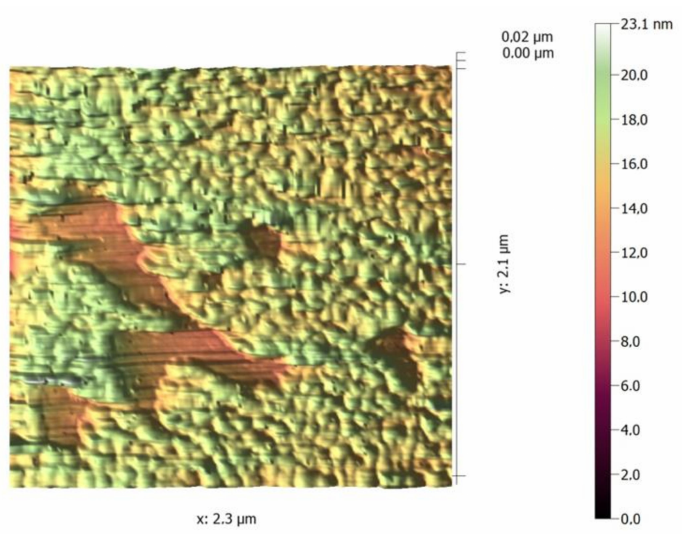
Figure 5. An AFM-image of the AgI surface after two consecutive one-hour exposures in the H 2 O 2 solutions of 10 − 8 M, 10 − 6 M, and 10 − 4 M